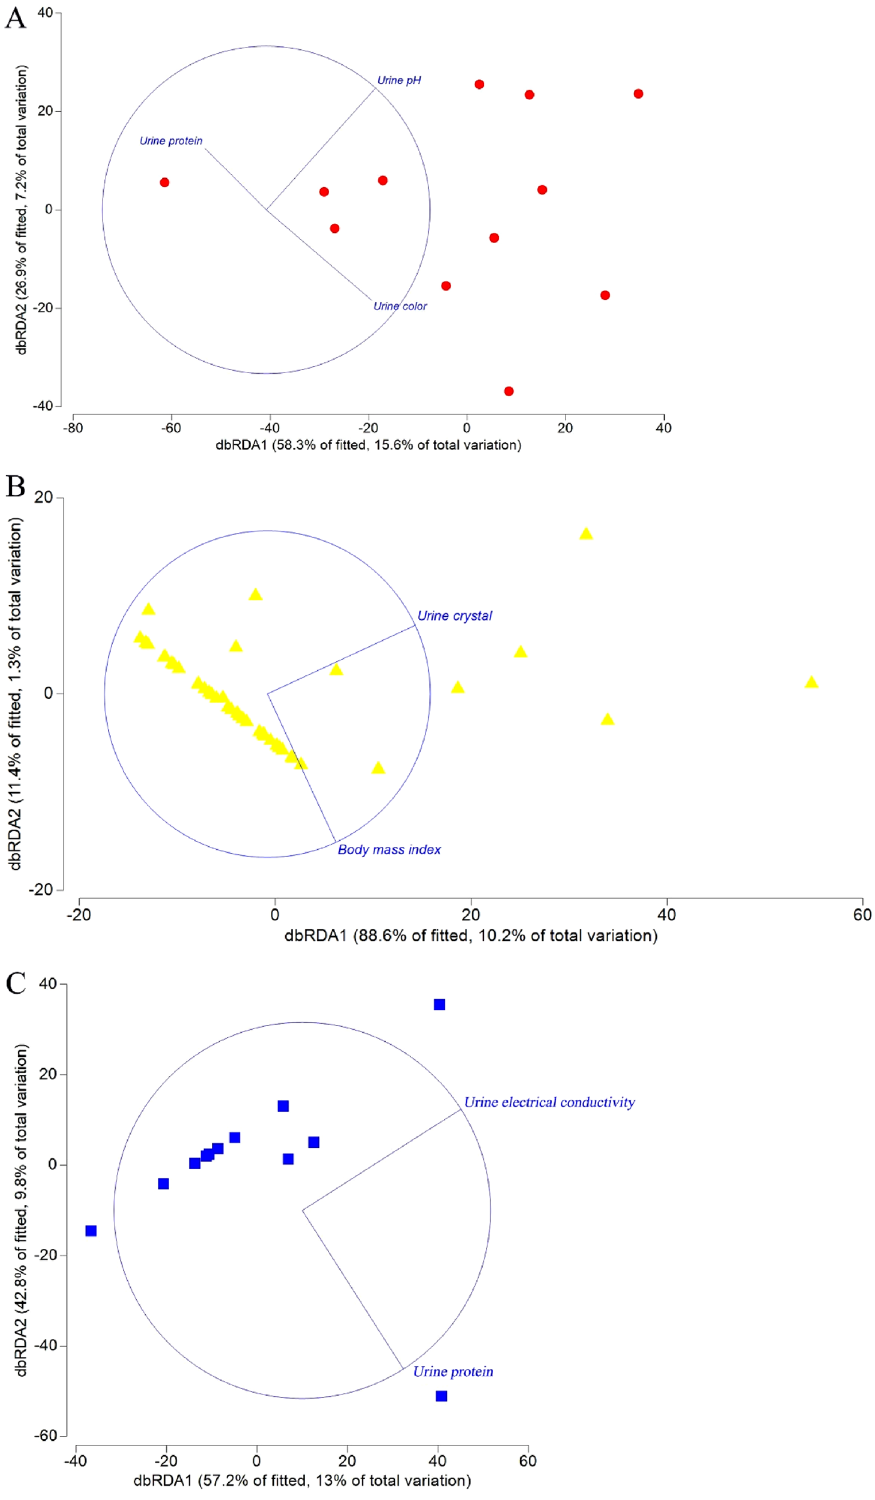
Figure 2. The urinalysis variables determined to affect the three clustered T2DM microbiomes, i.e., ( A ) Cluster_1_T2DM (red), ( B ) Cluster_2_T2DM (yellow) and ( C ) Cluster_3_T2DM (blue). Note: the analysis was carried out in a PRIMER7